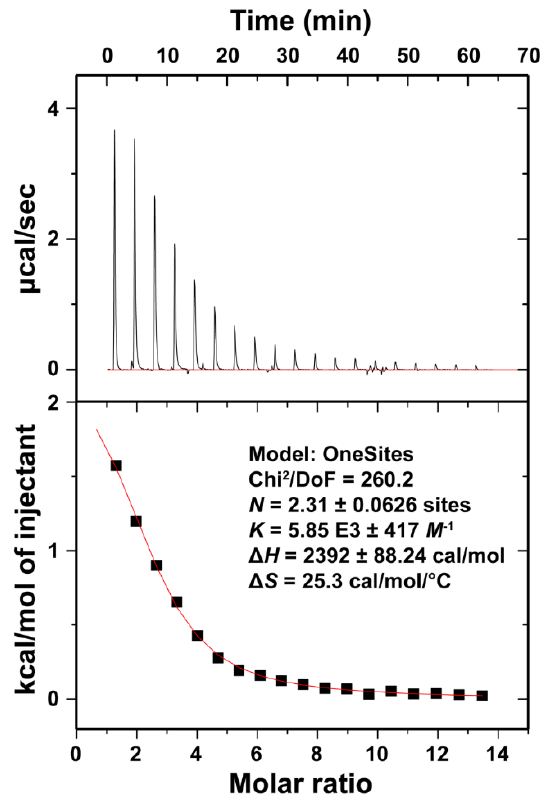
Figure 5. Isothermal titration calorimetry (ITC) analysis of Ca 2+ binding by the LT1002 anti-S1P antibody. Binding isotherms were measured as CaCl 2 was titrated into a Na-HEPES buffered solution containing LT1002. The data fit to a model in which slightly more than 2 ions bind per site with an equilibrium dissociation constant ( K D ) of 171 μ M.